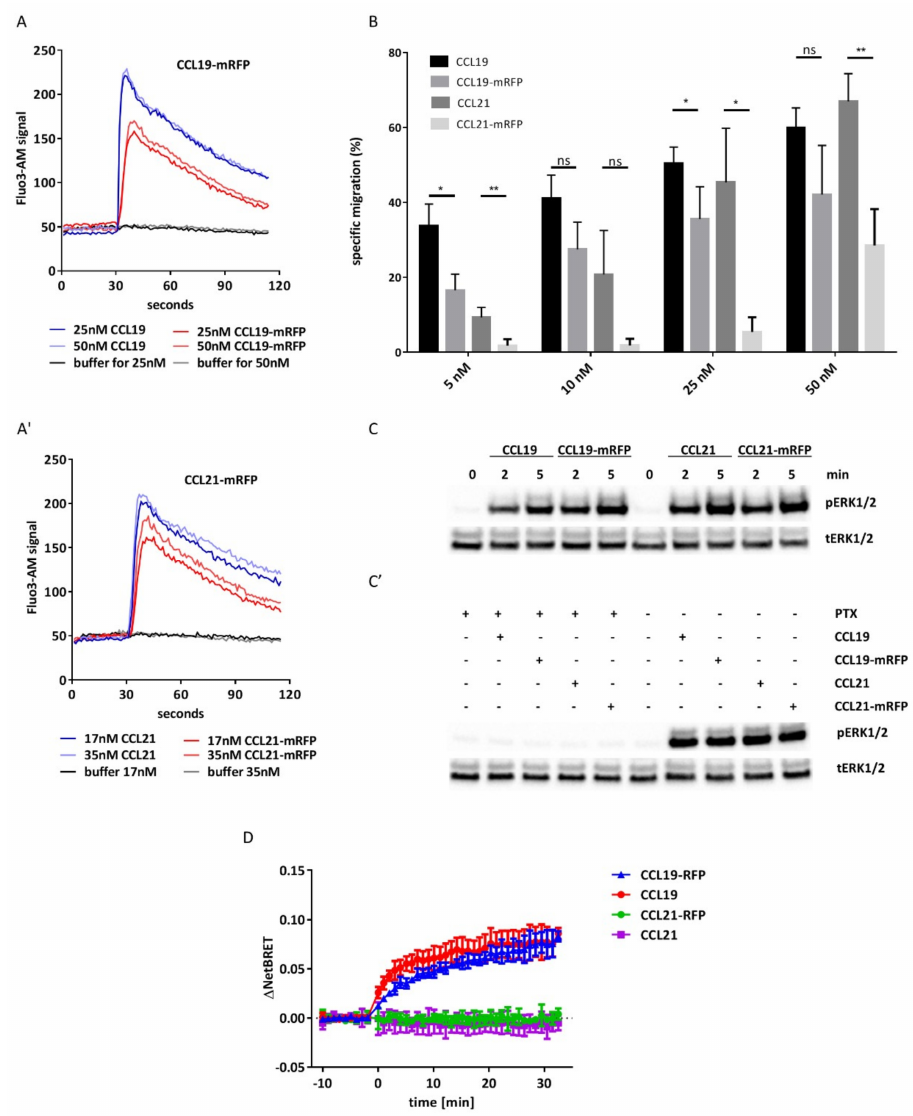
Figure 2. CCL19-mRFP and CCL21-mRFP are functional chemokines. ( A ) Real-time changes in [Ca 2+ ] i concentrations in CCR7 transfected 300-19 cells in response to graded concentrations of CCL19 and CCL19-mRFP (A) and CCL21 and CCL21-mRFP ( A (cid:48) ). A representative experiment out of three is shown. ( B ) Transwell chemotaxis of human mature MoDCs in response to chemokines. Human mature MoDCs were allowed to migrate in response to gradient concentrations of chemokines for 180 min. Migrated cells were counted and percentages of specifically migrated cells relative to the input were calculated. Mean values and SEM of duplicates derived from three independent experiments are shown. ( C ) Stimulation of human mature MoDCs with CCL19-mRFP and CCL21-mRFP results in the phosphorylation of ERK1/2. Human mature MoDCs were stimulated with 50 nM of CCL19, CCL19-mRFP or CCL21-mRFP for the indicated time points. ns: statistically not significant; * p < 0.05; ** p < 0.005. ( C’ ) MoDCs were pre-treated with 200 ng/mL PTx for 3 h and subsequently stimulated with 50 nM of chemokines for 5 min. Phosphorylation of ERK1/2 (pERK1/2) was determined by Western blotting. Re-probing the blots for total ERK1/2 (tERK1/2) served as a control for equal protein loading. ( D ) Chemokine-induced β -arrestin recruitment to CCR7. β -arrestin recruitment was determined by BRET upon stimulation with 50 nM of indicated chemokine. Mean values ± S.D. of 2 (CCL21, CCL21-mRFP) or 3 (CCL19, CCL19-mRFP) independent experiments with technical duplicates are